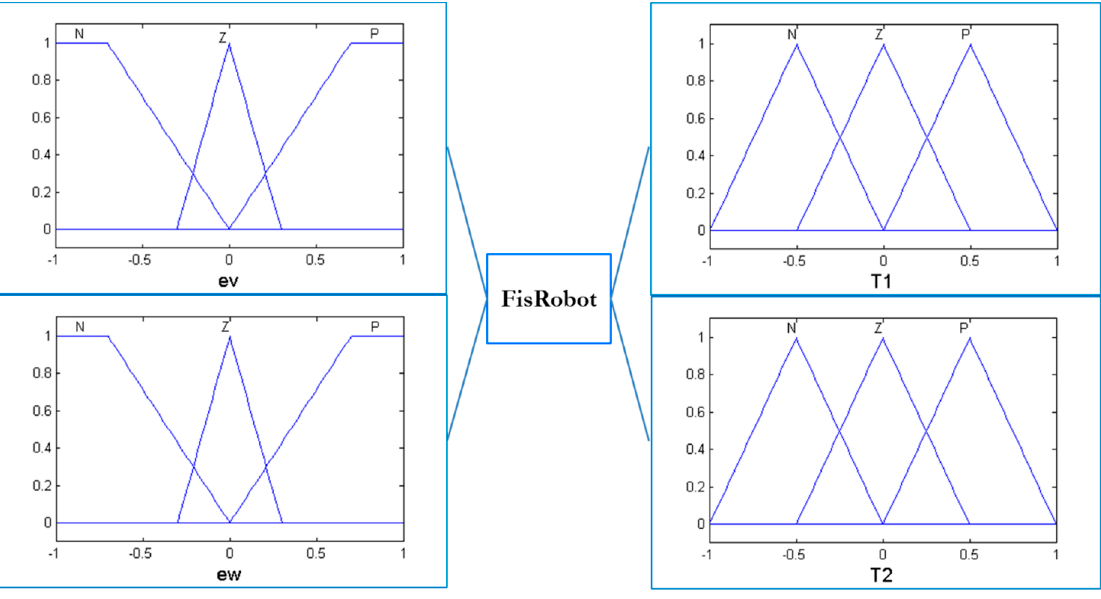
Figure 9. Fuzzy system for the fuzzy controller.